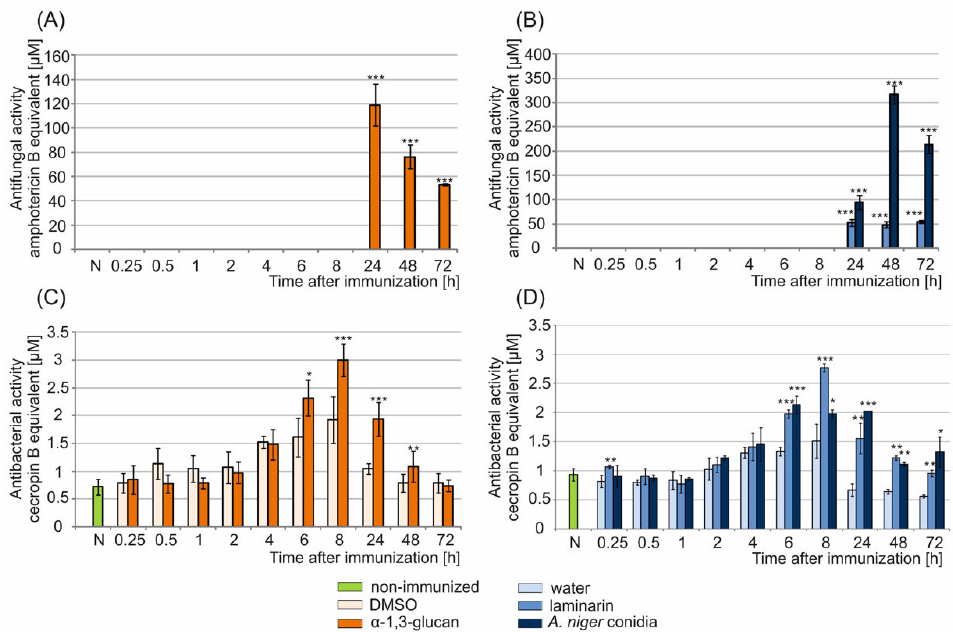
Figure 3. Antimicrobial activity in the hemolymph of G. mellonella larvae treated with A. niger α -1,3- glucan ( A , C ), A. niger conidia, or laminarin ( B , D ). The larvae were injected with A. niger α -1,3-glucan (5 µ g), A. niger conidia (1 × 10 5 ), or laminarin (50 µ g). The control larvae were injected with DMSO or water as described in the Materials and Methods. The hemolymph was collected at the indicated time points and antifungal ( A , B ) and antibacterial ( C , D ) activity was detected on solid agar plates against A. niger and E. coli , respectively. The antifungal and antibacterial activity was expressed as amphotericin B and cecropin B equivalents, respectively. N—non-immunized larvae. Statistically significant differences between the mean values (from three independent experiments) obtained at the respective times after immunization with α -1,3-glucan and DMSO or after immunization with conidia and water are marked with asterisks: * p < 0.05, ** p ≤ 0.01, *** p ≤